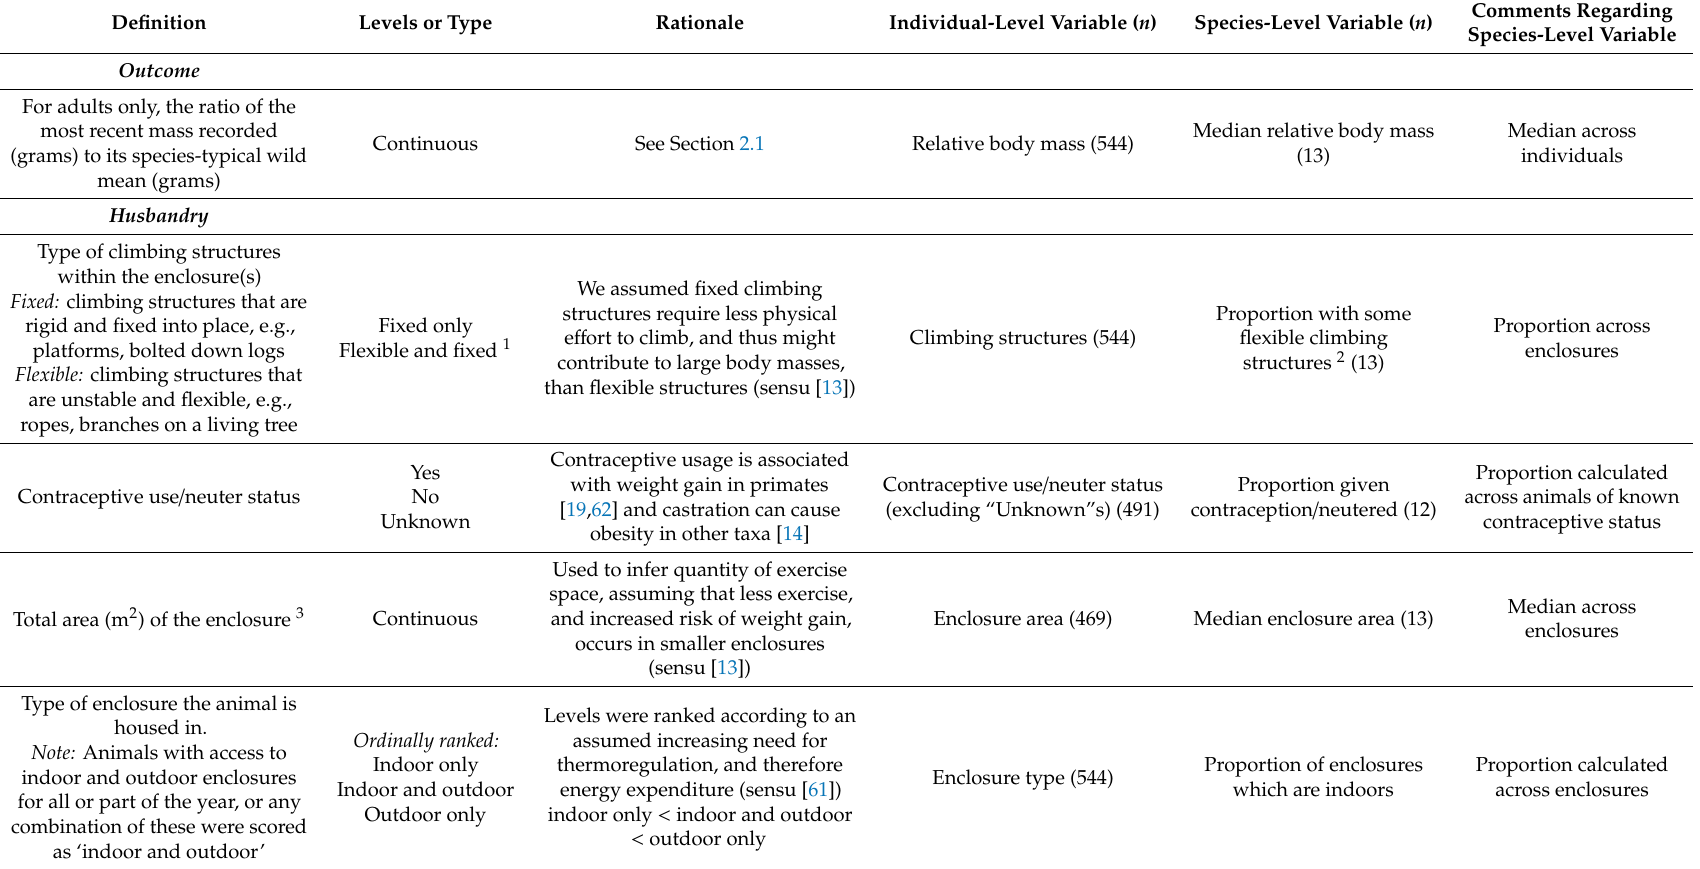
Table 1. Details of survey data processing. Individual-level variables are those used in the epidemiology analyses ( n = number of animals with data), and species-level are those used for comparative analyses ( n = number of species with data). Note that a subset of the total available data, from the four best-sampled species, was used for epidemiological analyses (see Section